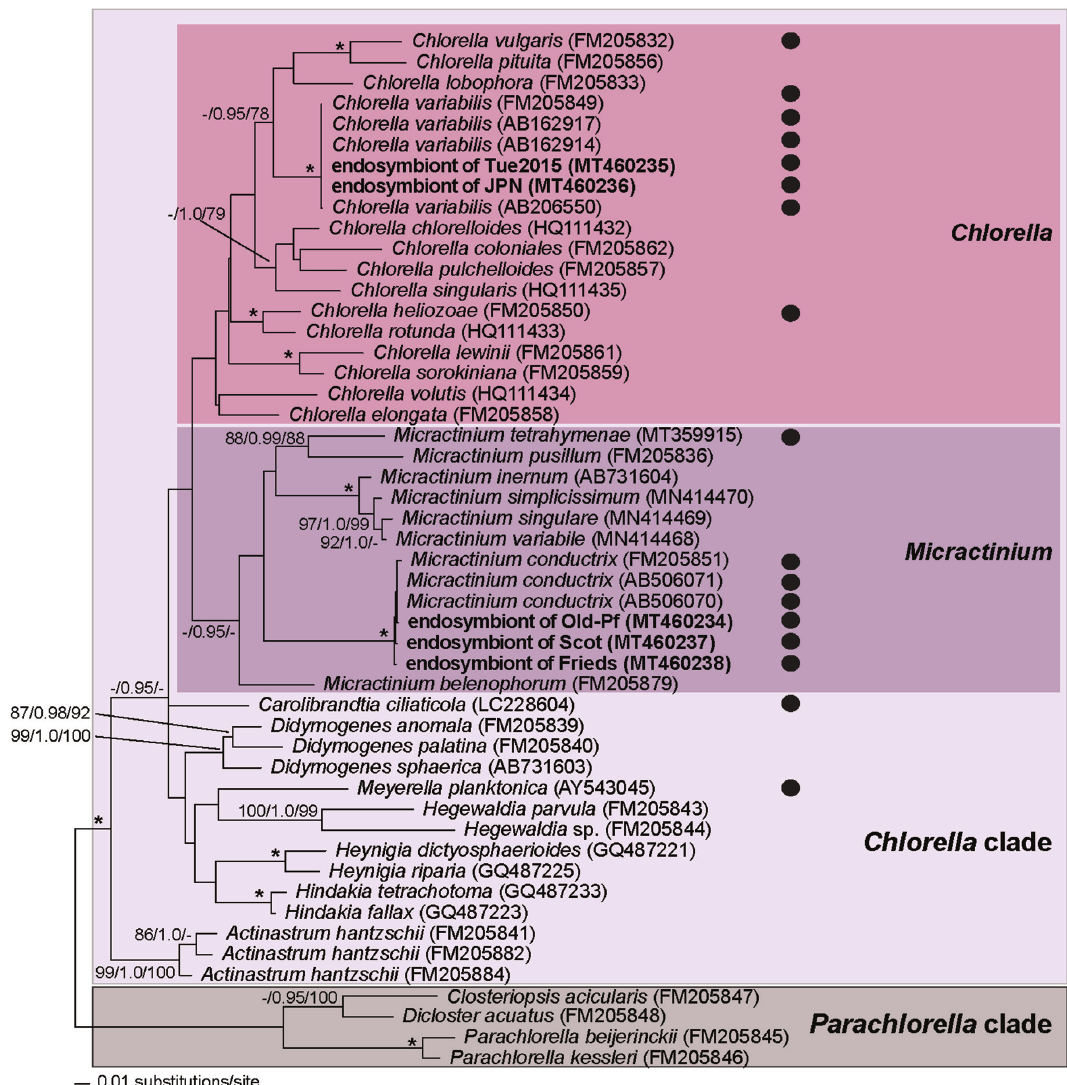
Figure 5. Molecular identification of microalgal endosymbionts. Phylogeny of members of the Chlorellaceae based on sequences covering the SSU rRNA gene and the internal transcribed spacer region spanning ITS1-5.8S-ITS2. The shown tree was inferred by the Neighbour Joining method based on 2224 aligned positions. GTR + I + G was used as evolutionary model. Bootstrap values above 70 % and Bayesian Interference values above 0.95 are indicated (ML/BI/NJ). Asterisks indicate maximum support in all analyses. Members of the Parachlorella clade were selected as outgroup. Black circles indicate species capable of living in symbiosis. The sequences marked in bold were obtained in this